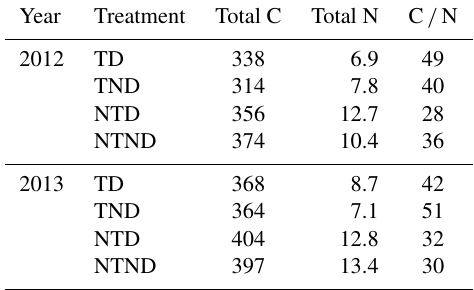
Table 6. Total C (gkg − 1 ) and total N (gkg − 1 ) contents in rice stub- ble before early-rice transplanting in 2012 and